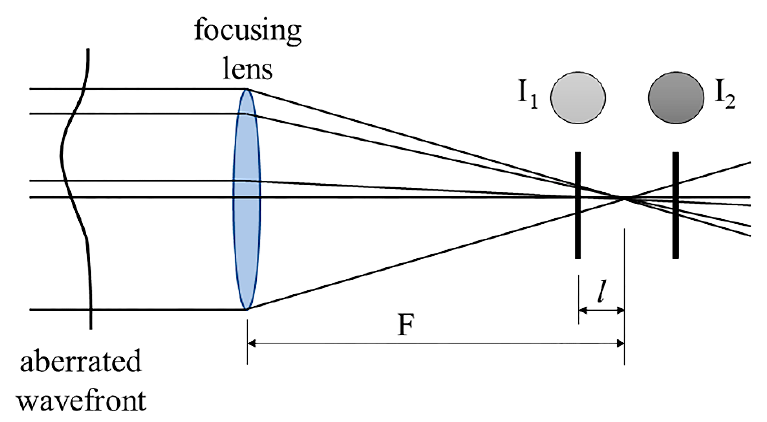
Figure 6. Principle of the curvature wavefront sensor. The wavefront curvature distribution can be evaluated by measuring the non-uniform illumination at two positions, before and after the pupil plane. Figure reprinted from Ref. [15] New methods and techniques for sensing the wave aberrations of human eyes, M. Lombardo and G. Lombardo, Clinical and Experimental Optometry , 2009 Taylor & Francis Ltd., with permission of the publisher (Taylor & Francis Ltd., Abingdon-on-Thames, UK, http://www.tandfonline.com).